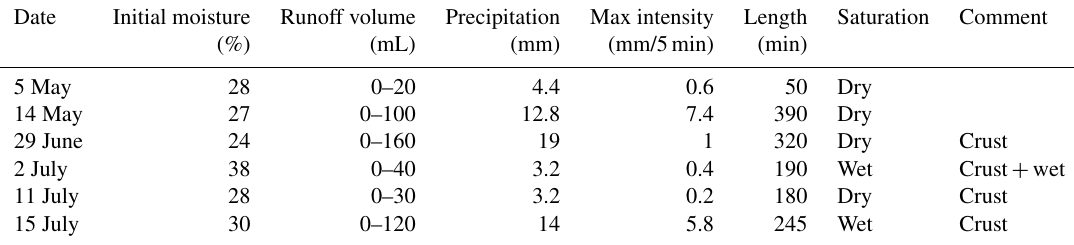
Table 3. Rainfall events used for the skinfactor validation.